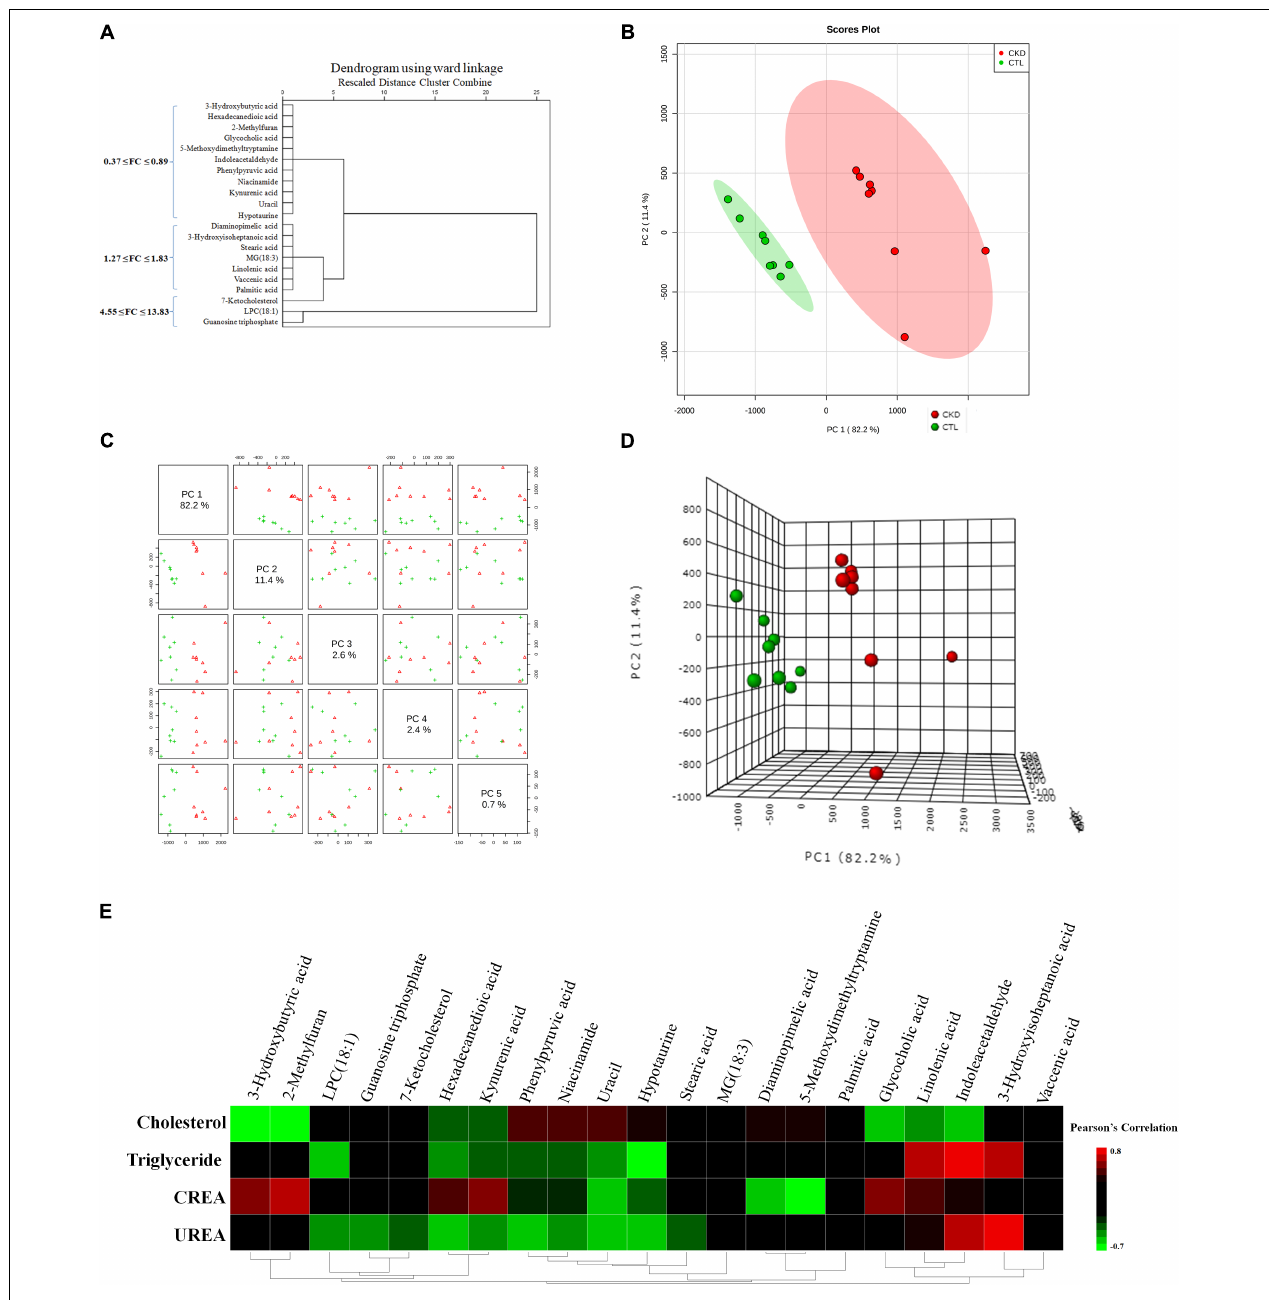
FIGURE 4 | (A) Hierarchical clustering dendrogram of the identified significant metabolites. The (B) 2D PCA and (D) 3D PCA score scatter plot using 21 differential metabolites from 8 CKD rats and 8 control rats. The unsupervised PCA score plots showed that 21 differential metabolites could separate CKD group from the control group. (C) Different principal components have a different contribution to separating CKD from healthy controls in this study. Red triangles and green crosses represent CKD samples and control samples, respectively. (E) Associations of metabolites with clinical indices. Heat map of the Pearson’s rank correlation coefficient between 4 clinical indices and 21 differential